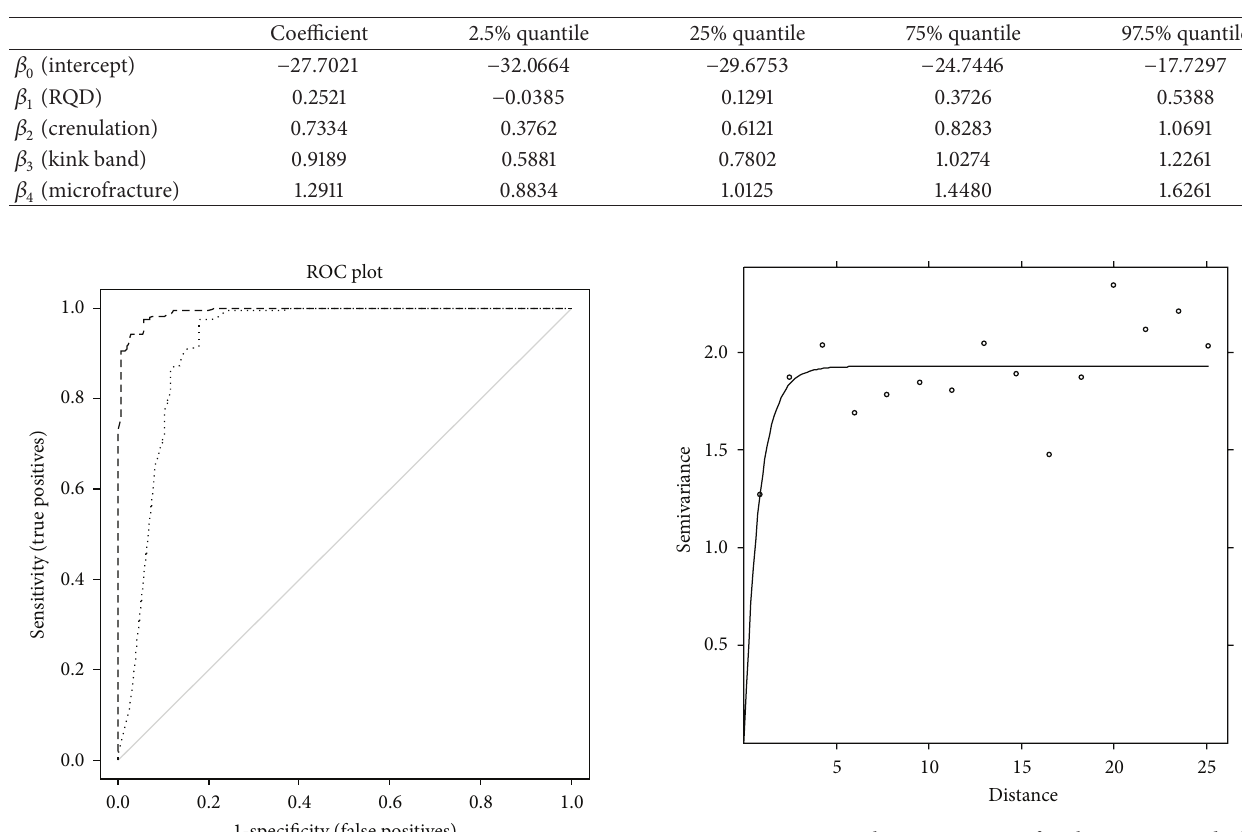
Figure 2: Experimental semivariogram for the GLM2 residuals (points), together with the fitted theoretical model fitted according to an exponential model (continuous